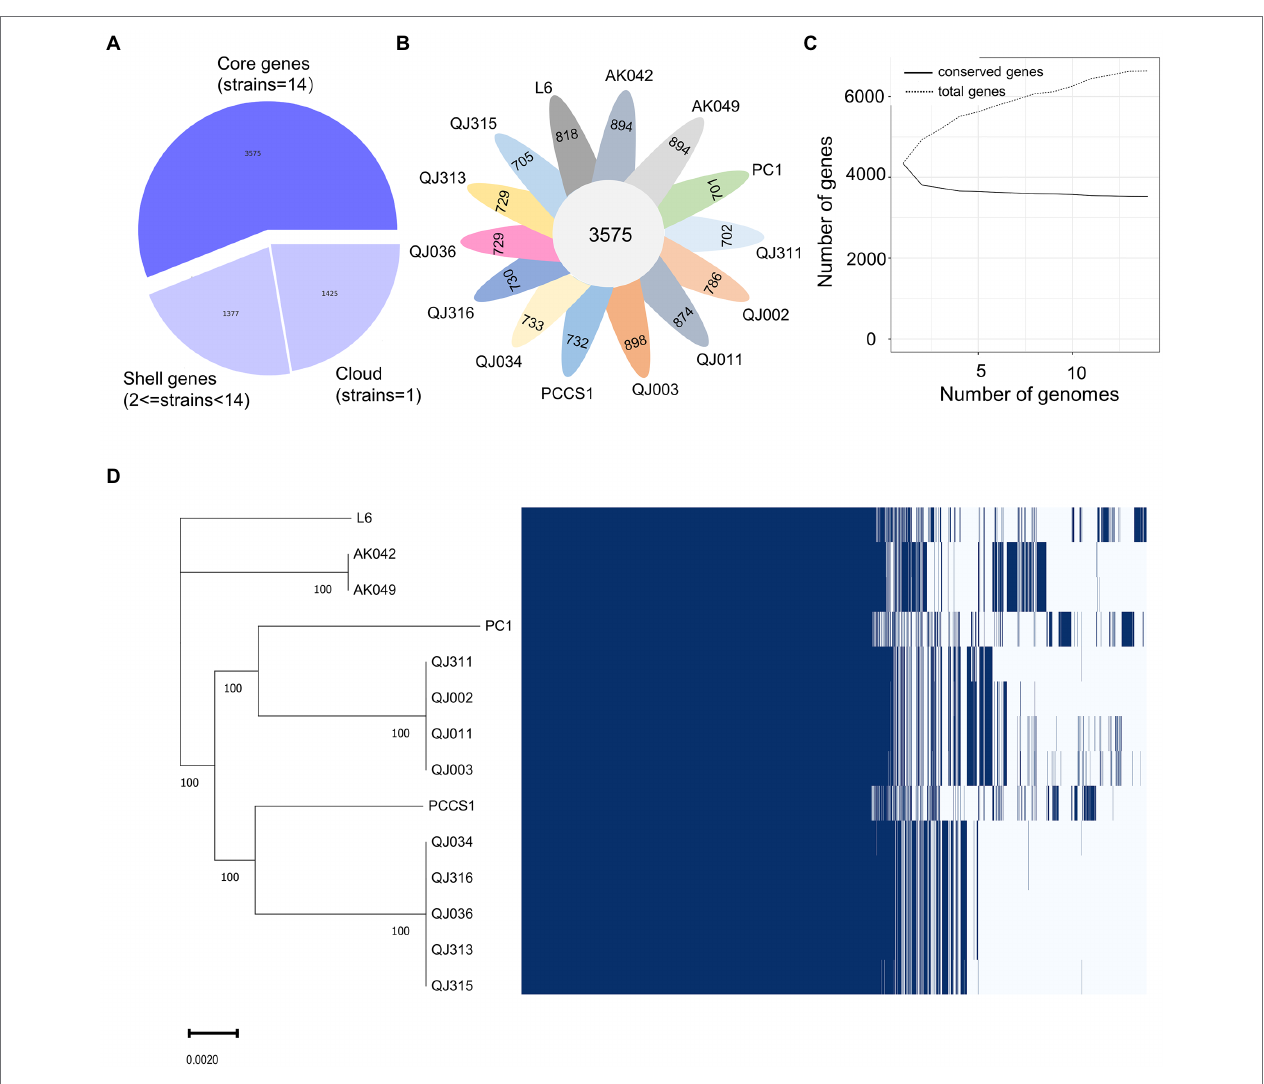
FIGURE 4 | Pangenome analysis of 14 Pectobacterium aroidearum strains conducted with the Roary pipeline. (A) A pie chart displays the proportion of genes in the core, shell, and cloud of the pangenome. (B) A follower plot shows the number of core genes and accessory genes in each P . aroidearum strain. (C) The size of the core genome and pangenome with the increasing numbers of P . aroidearum genomes. (D) Gene presence–absence matrix shows the distribution of genes in each genome. The maximum likelihood (ML) tree is based on all the core gene alignment of the 14 P . aroidearum genomes. Each column represents an orthologous gene family. Dark blue blocks and light gray indicate the presence or absence of a gene,